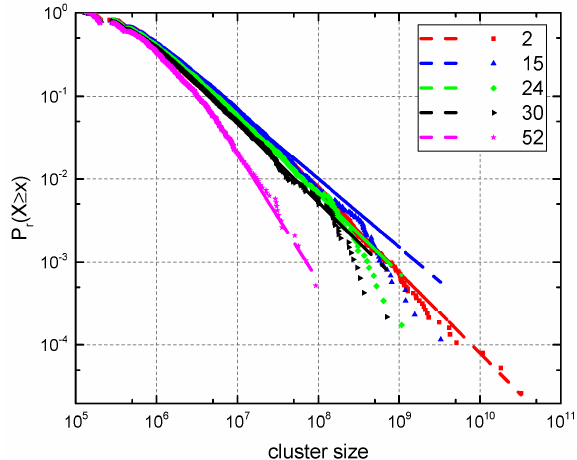
Figure 5. The log-log plot of the power-law distributions of the NTL cluster sizes at varying thresholds. When the potential threshold DN P is set to 2 (red), 15 (blue), 24 (green), 30 (black), and 52 (magenta), the cumulative density distribution of the cluster sizes at each threshold is shown in the corresponding color, and its statistical power-law distribution function is displayed as the dotted line in the same color.